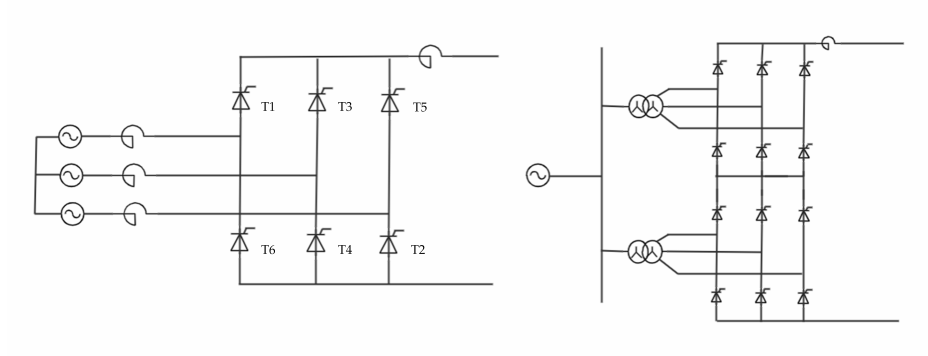
Figure 1. Schematic diagrams of converter valve(s), 6 pulse converters and 12